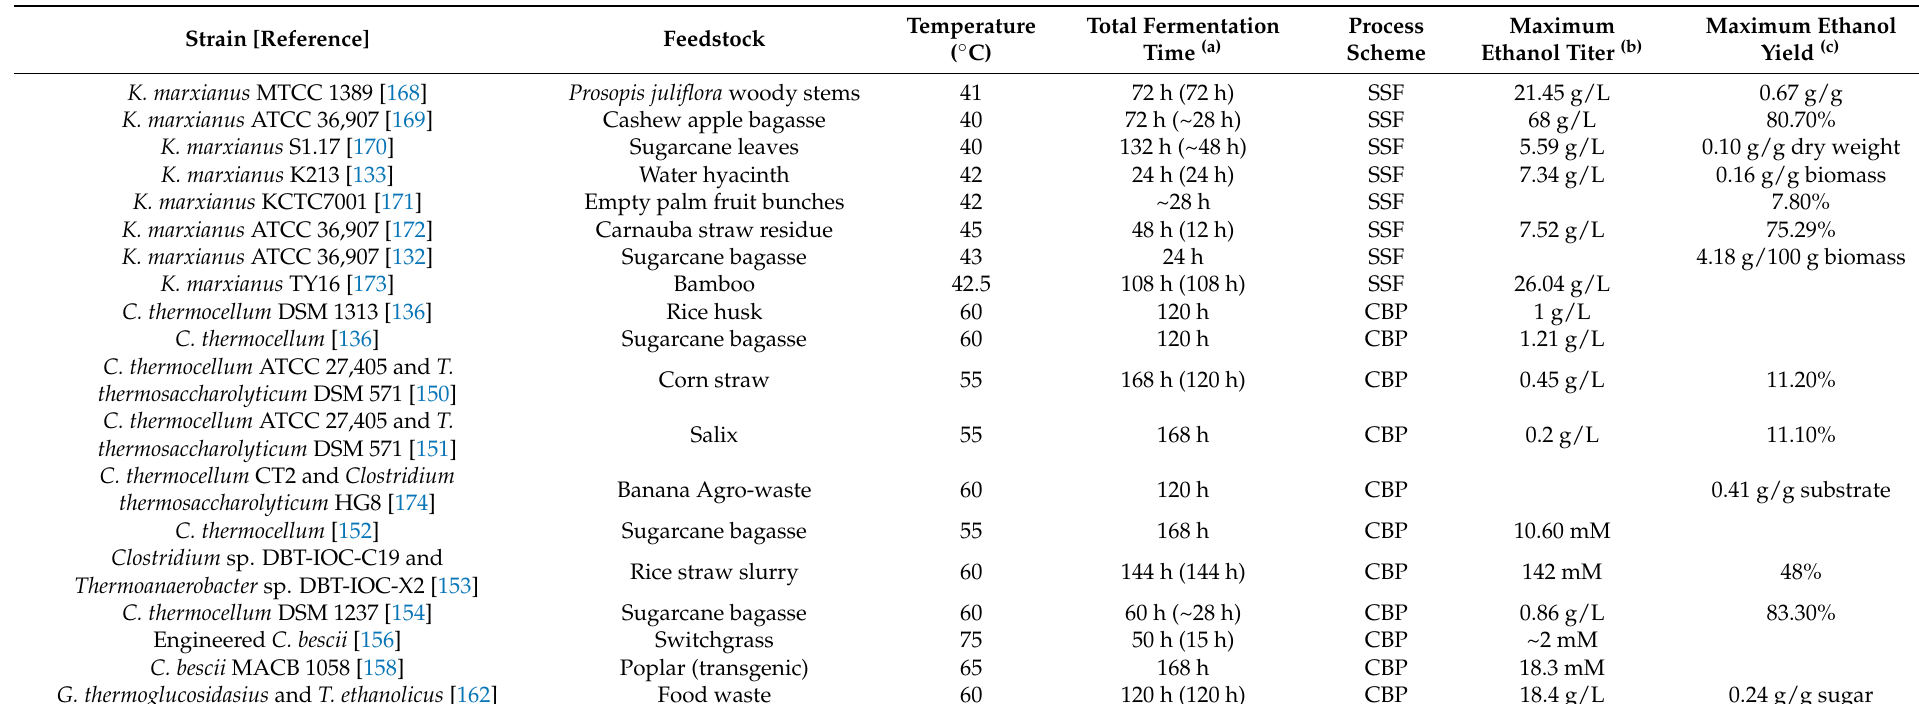
Table 2. Examples of thermophiles implementation into bioethanol fermentation using industrially relevant